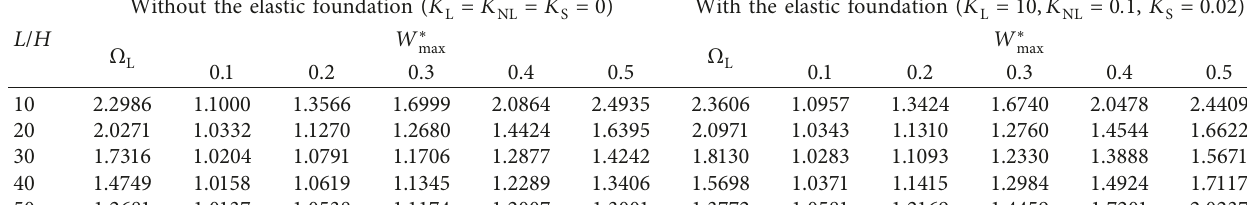
Table 6: Effects of the slenderness ratio on ω